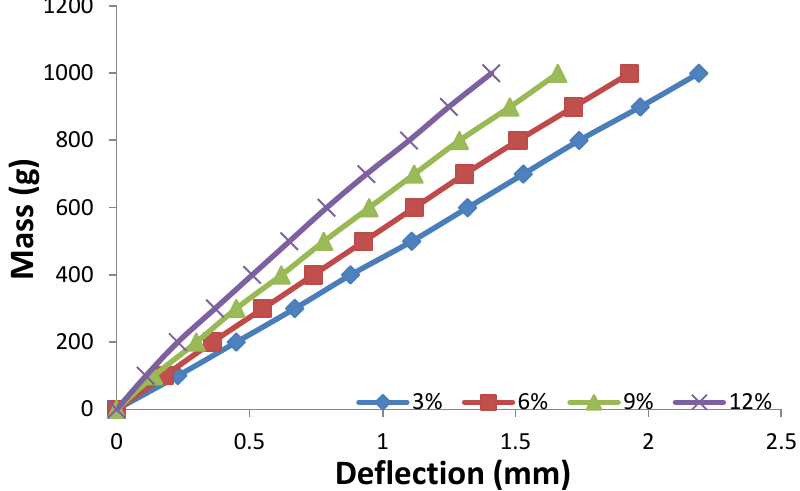
Fig. 3: Mass vairation with different concentrations of SiO